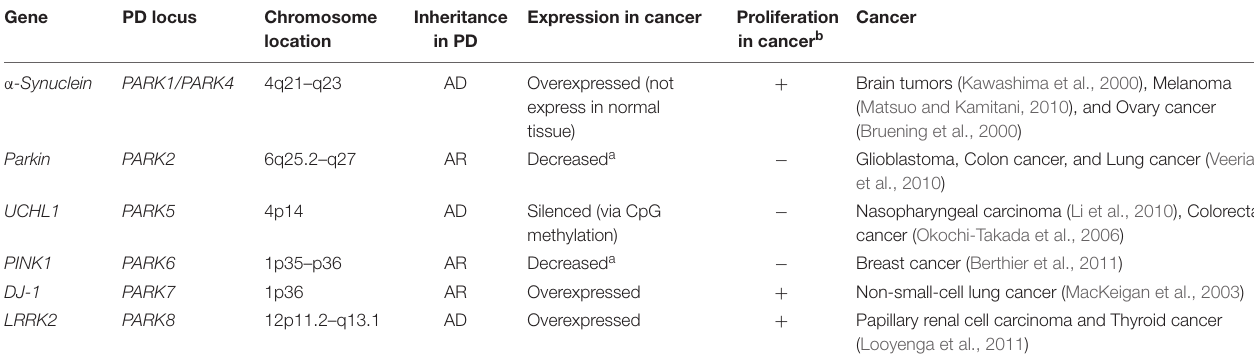
TABLE 1 | Parkinson’s disease (PD) involved genes identified in